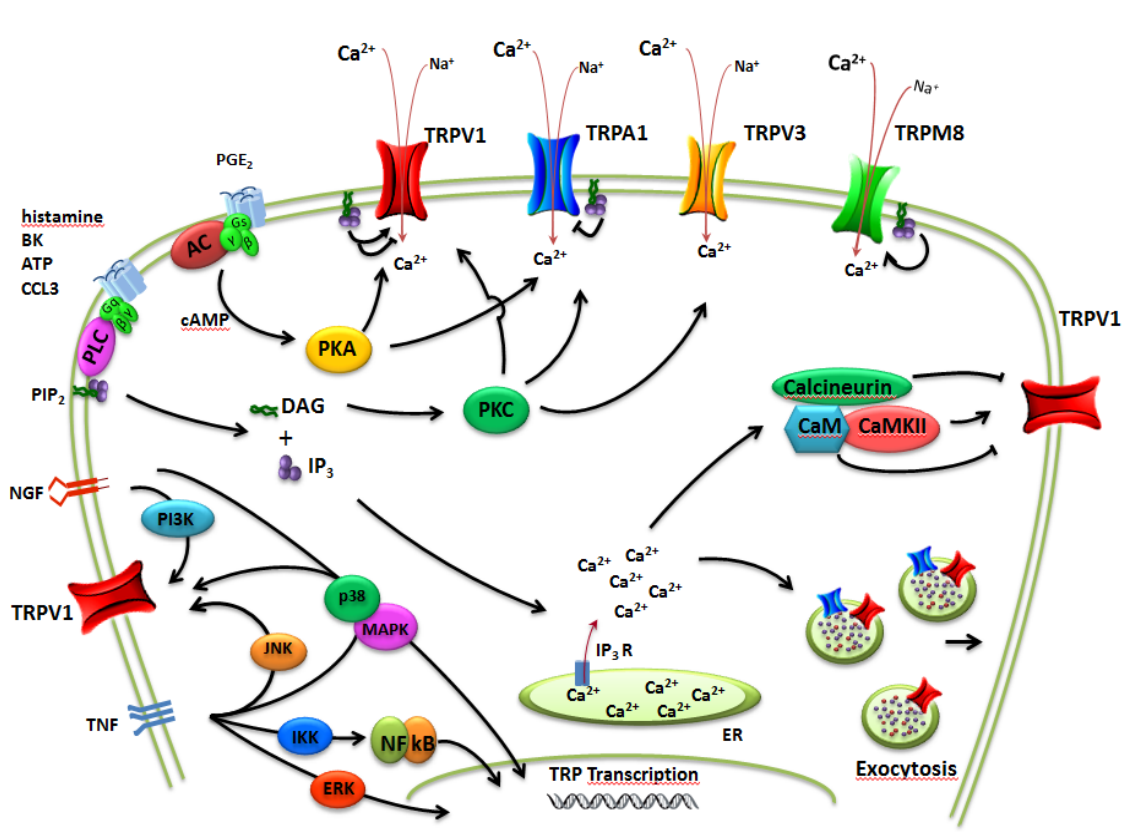
Figure 3. Schematic diagram of complex regulation of thermoTRP implicated in pain transduction. This scheme illustrates how TRP channels may not only act as ligand-gated ion channels but may also increase neuron excitability through the activation of intracellular signaling